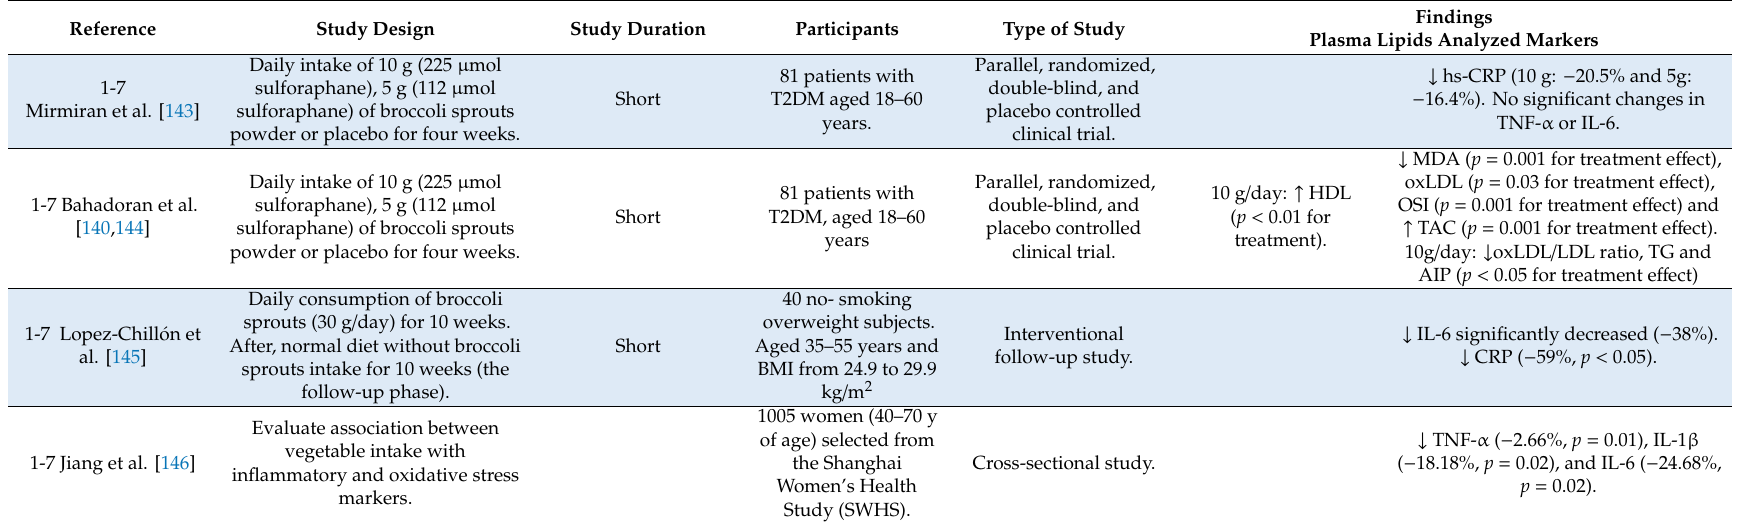
Table 5. Potential protective e ff ect of broccoli or its bioactive compounds on proinflammatory and oxidative stress markers during the progression of